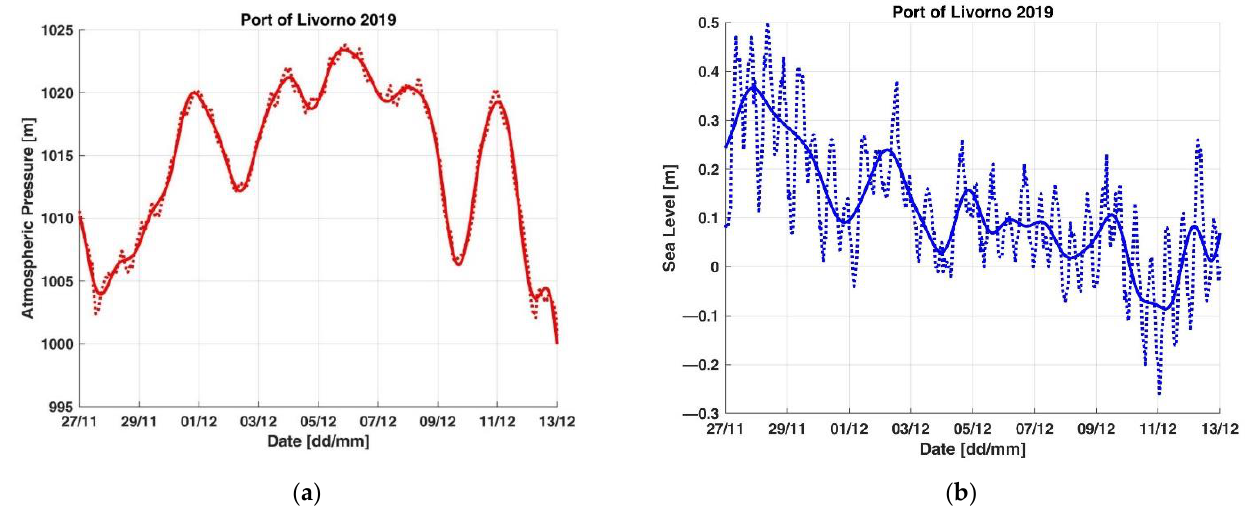
Figure 12. Low-frequency components of meteomareographic parameters acquired by ISPRA’s monitoring station in the port of Livorno from 27 November to 13 December 2019: ( a ) atmospheric pressure; ( b ) sea level; solid lines: low-frequency components surviving the filtering; dashed lines: high-frequency components eliminated by the filtering.